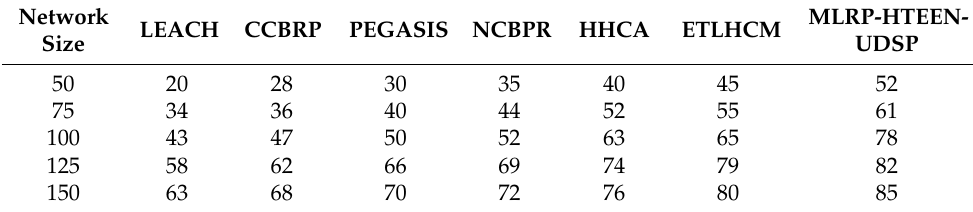
Table 3. Comparison of throughput.